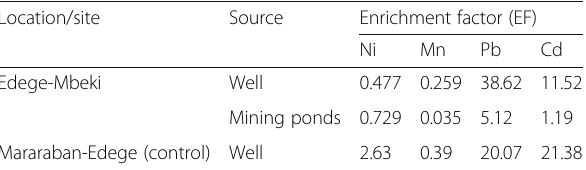
Table 6 Enrichment factor for water samples using iron (Fe) as a reference element for average